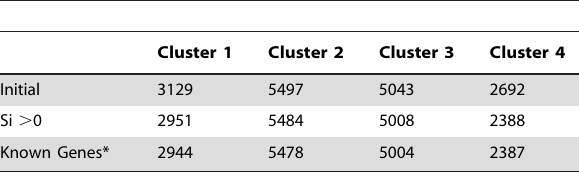
Table 1. The number of genes in each cluster